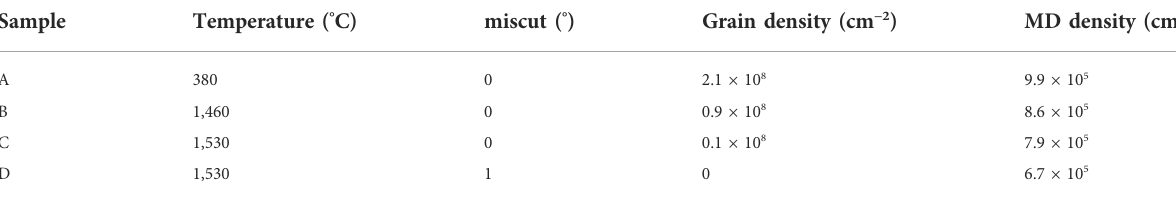
TABLE 1 Growth conditions and structural characterization of samples A, B, C, and D. Sample